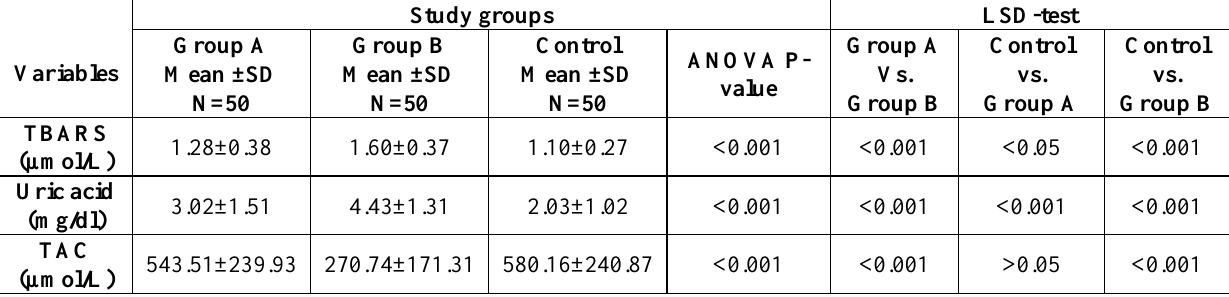
Table 1: Salivary oxidative stress markers of T2DM patients according to arterial stiffness index (ASI) in comparison with controls